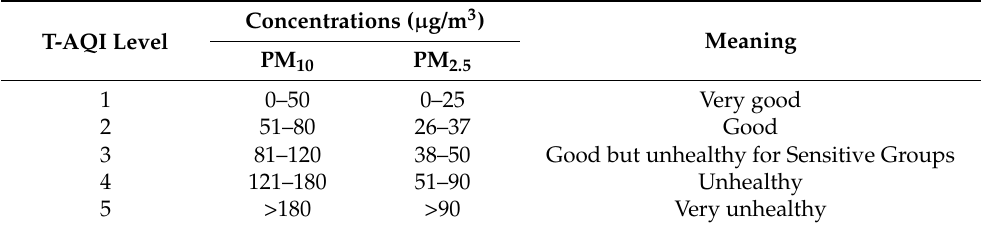
Table 1. Definition and range of Thailand air quality index from PM 10 and PM 2.5 .